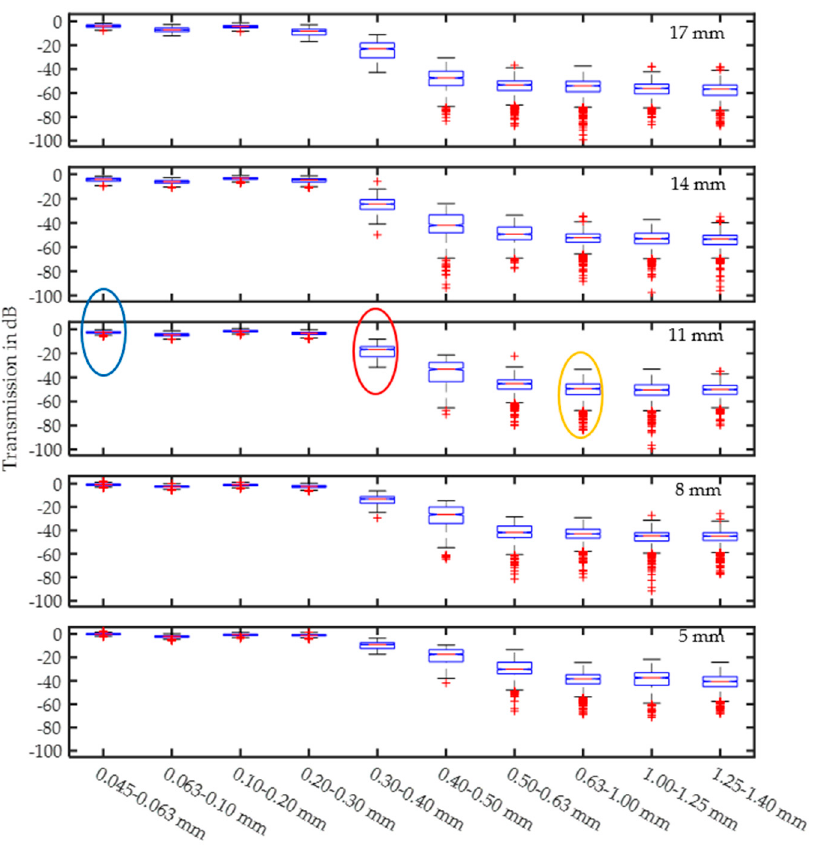
Figure 11. Averaged signal amplitudes for different quartz fractions at different sample